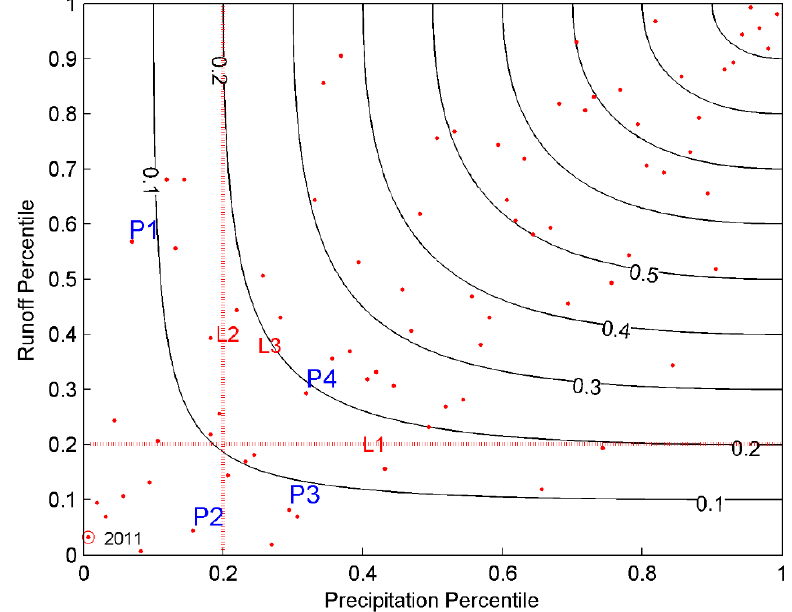
Figure 4. Comparison of individual and compound drought based on the percentile of precipitation and runoff (6-month time scale) for the period 1932–2011 using copula. The circled point represents the data pairs during 2011.